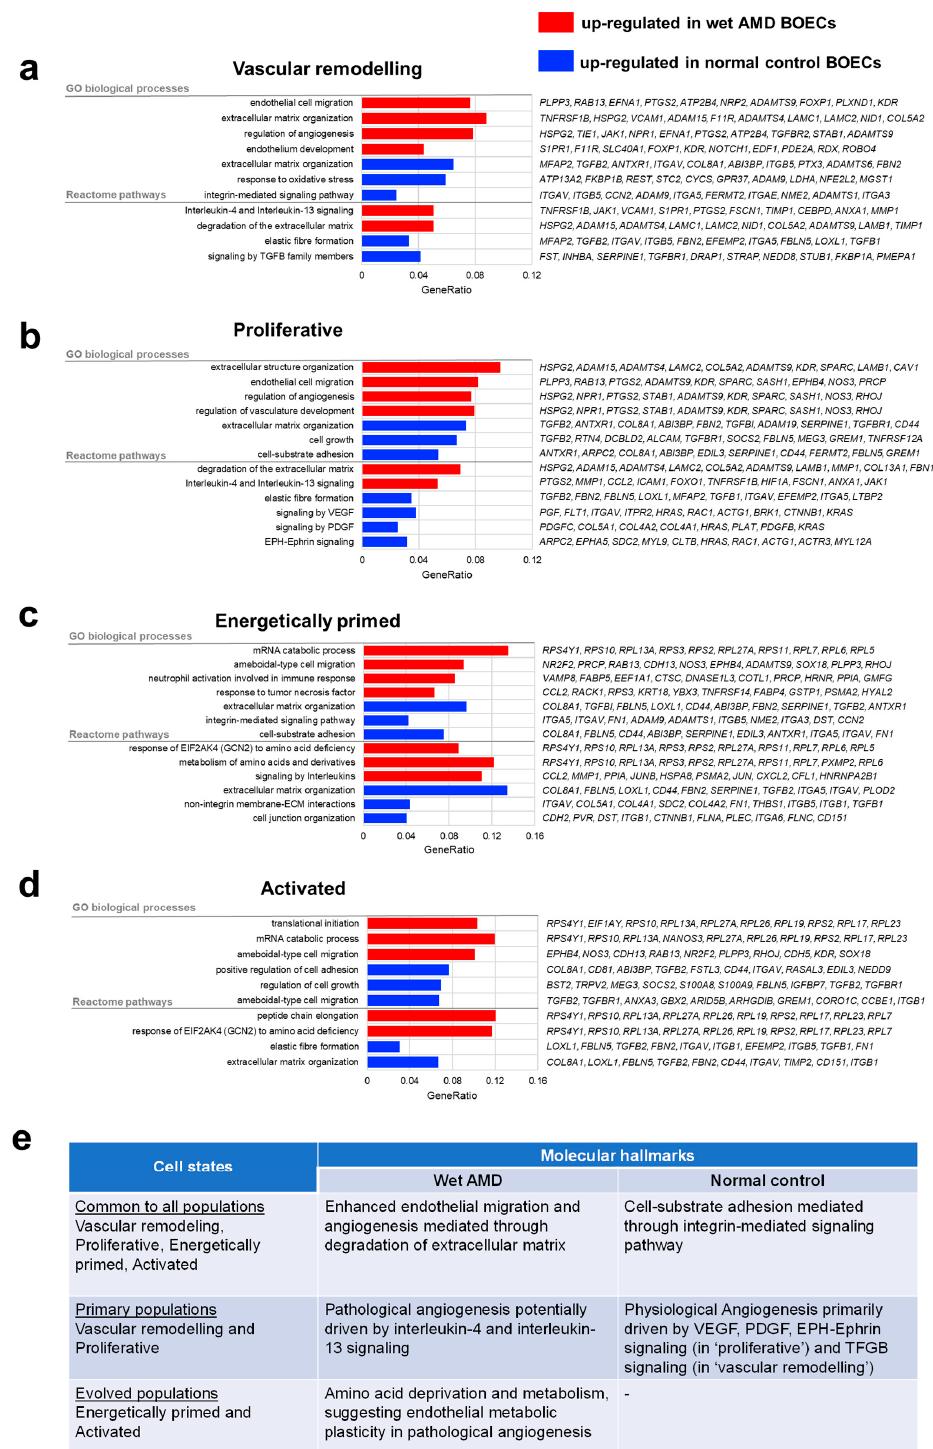
Figure 2. Wet AMD endothelial cells reveal pathological angiogenesis hallmarks. ( a – d ) Enrichment of top 100 differentially expressed genes (p. adj < 0.05) based on gene ontology biological processes and Reactome Pathway knowledgebases, for each of the four clusters as indicated. The top enriched processes and pathways are shown. Red bars represent wet AMD BOEC-upregulated processes, while blue bars represent normal BOEC-upregulated processes. ( e ) Summary of molecular hall- marks comparing wet AMD and normal BOECs that are common to all populations and found in primary/evolved